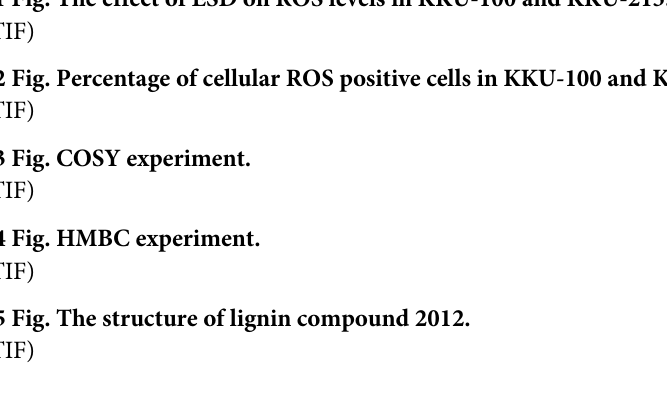
S1 Fig. The effect of ESD on ROS levels in KKU-100 and KKU-213. S2 Fig. Percentage of cellular ROS positive cells in KKU-100 and KKU-213.